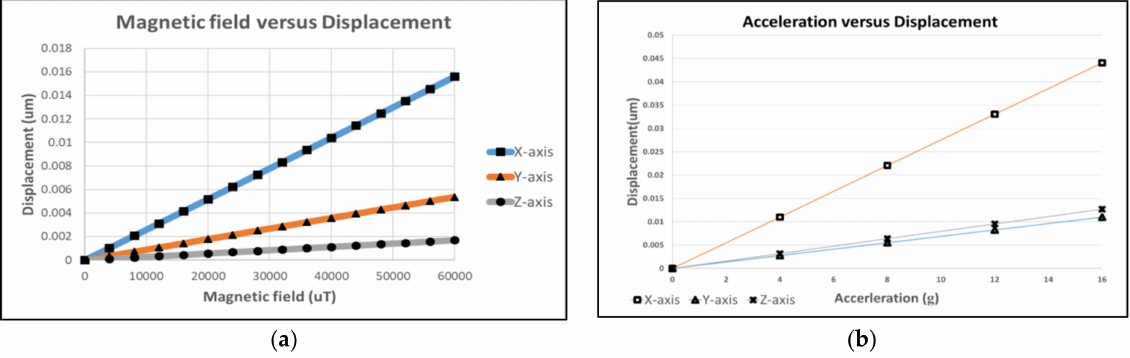
Figure 6. ( a ) Acceleration versus displacement of the three-axis; ( b ) magnetic field versus displacement of the